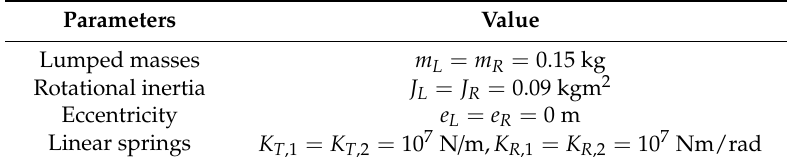
Figure 2. The three-span pipe model. Table 1. The physical properties of the pipe model.